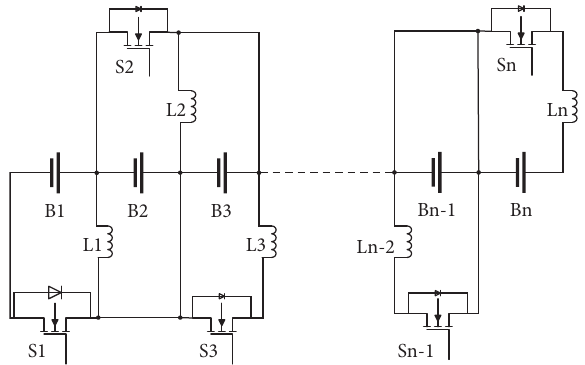
Figure 3: Classical inductor equalization circuit